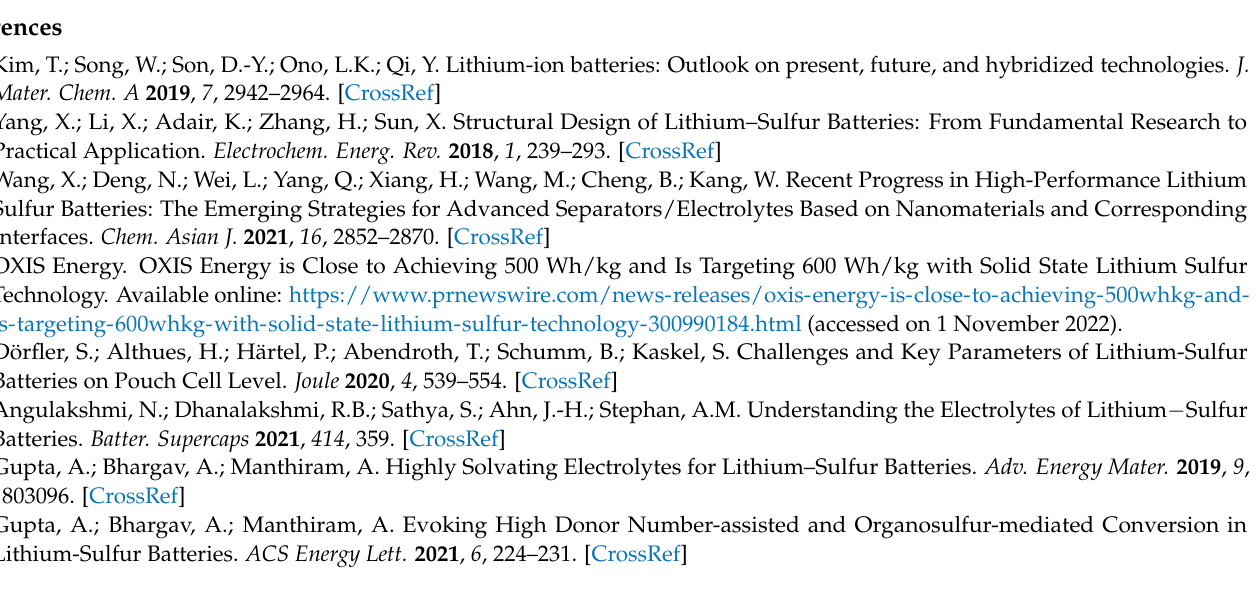
Figure S3. Voltage profiles of TMG:DOL 1:1 with varying LiTFSI concentration: ( a ) 1 M, ( b ) 1.5